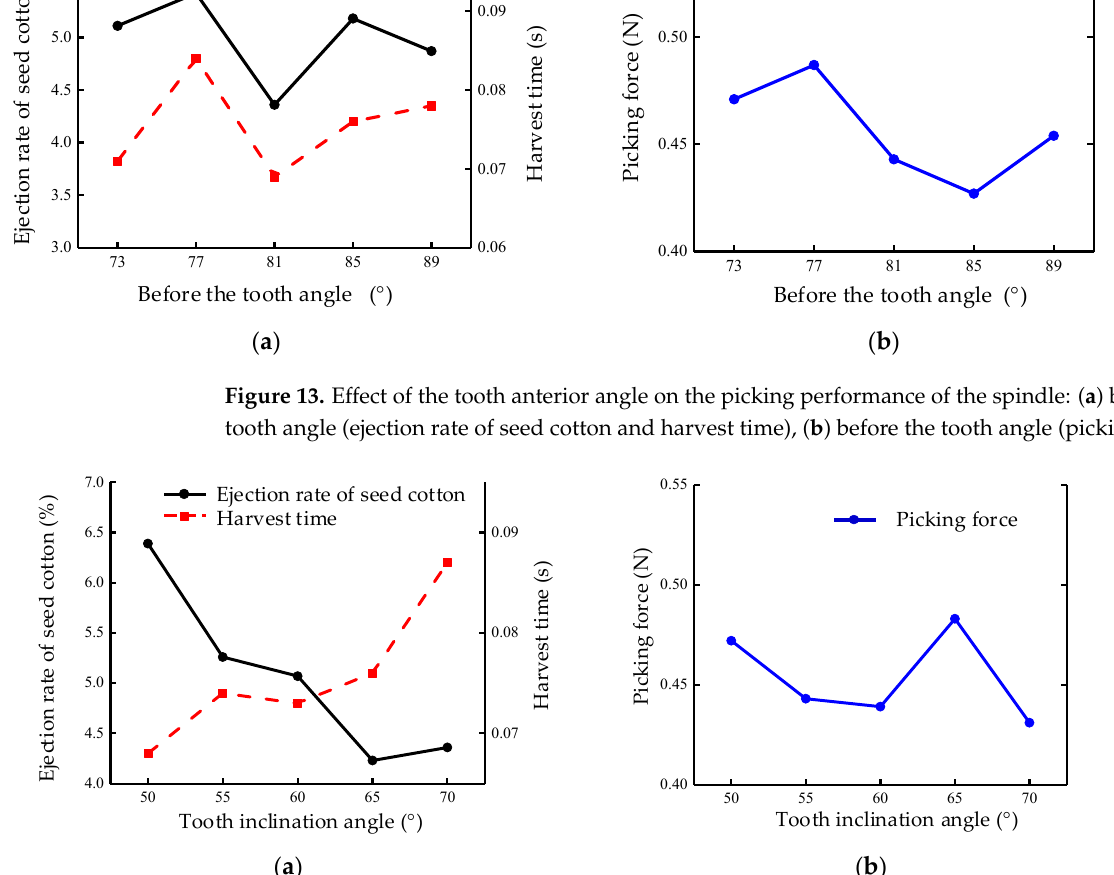
Figure 14. Effect of the tooth inclination angle on the picking performance of the spindle: ( a ) tooth inclination angle (ejection rate of seed cotton and harvest time), ( b ) tooth inclination angle (picking force). Overall, the selection of the factors associated with the tooth groove angle should be as large as possible to reduce the ejection rate of seed cotton as well as picking time.